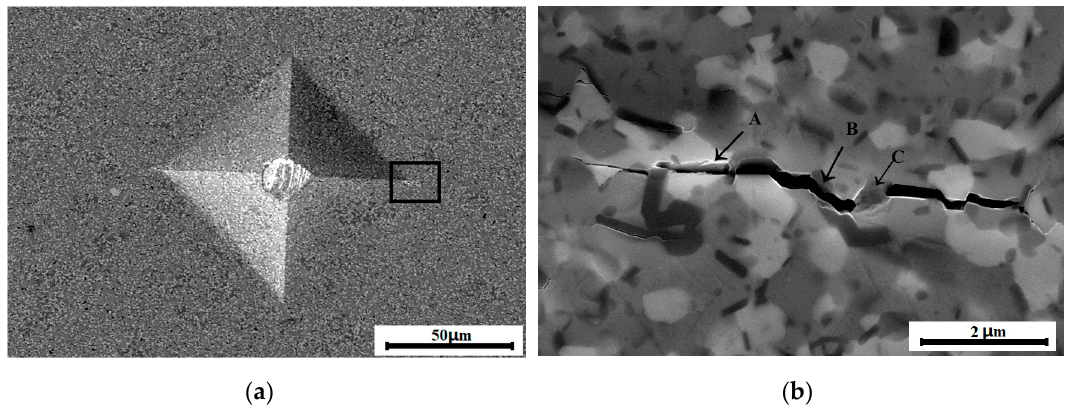
Figure 7. The indentation morphology of the Vickers indentation ( a ) and the crack generated by the indentation ( b ).